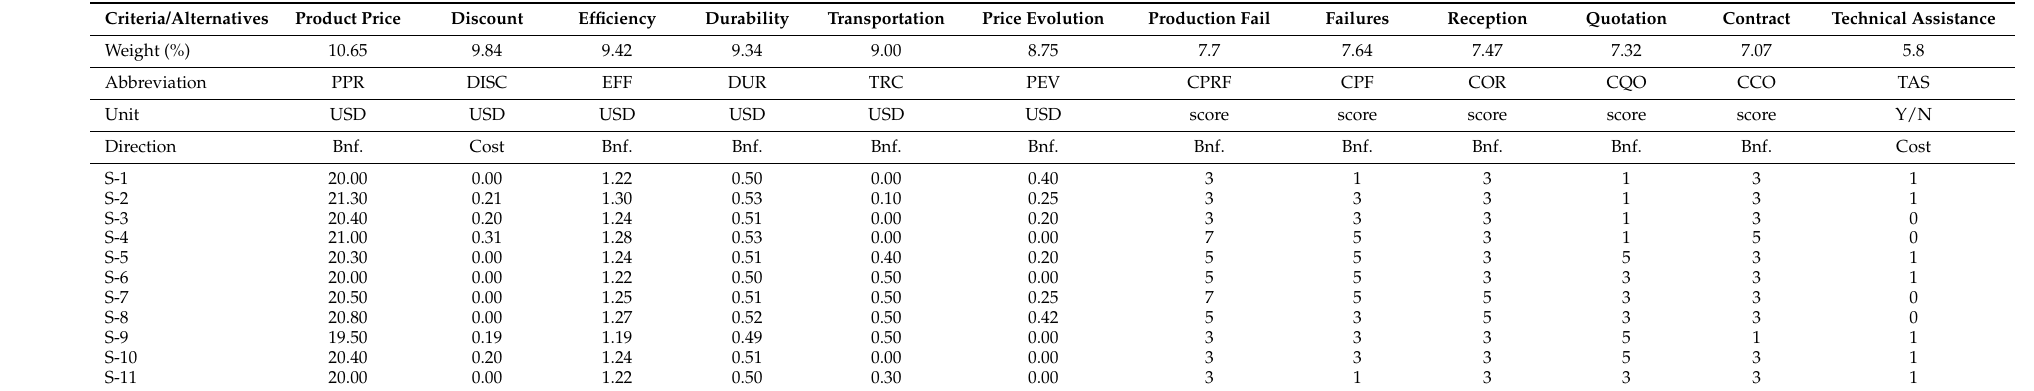
Table 10. Global Evaluation Matrix (X) for Chemical Fertilizer.